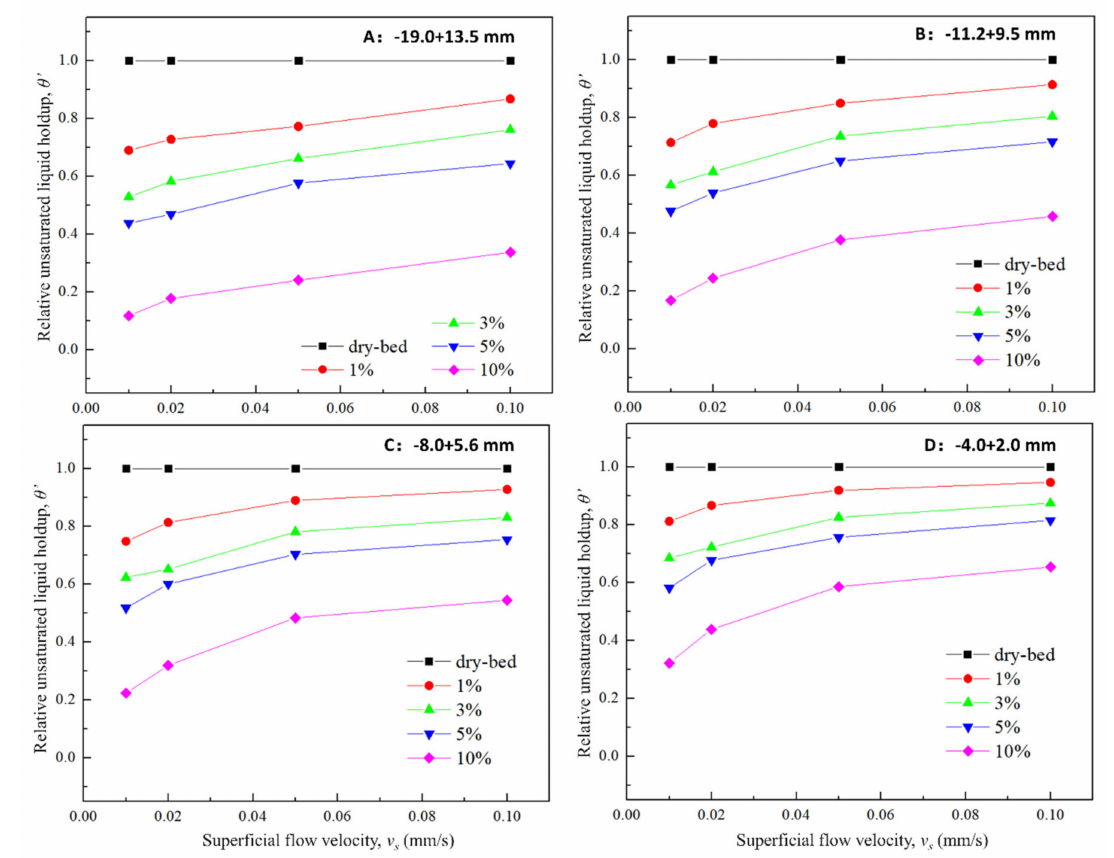
Figure 7. The relationship between superficial flow rate and relative liquid holdup under different geometric mean diameters and initial moisture contents. ( A ): − 19.0 + 13.5 mm; ( B ): − 11.2 + 9.5 mm; ( C ): − 8.0 + 5.6 mm; ( D ): − 4.0 + 2.0